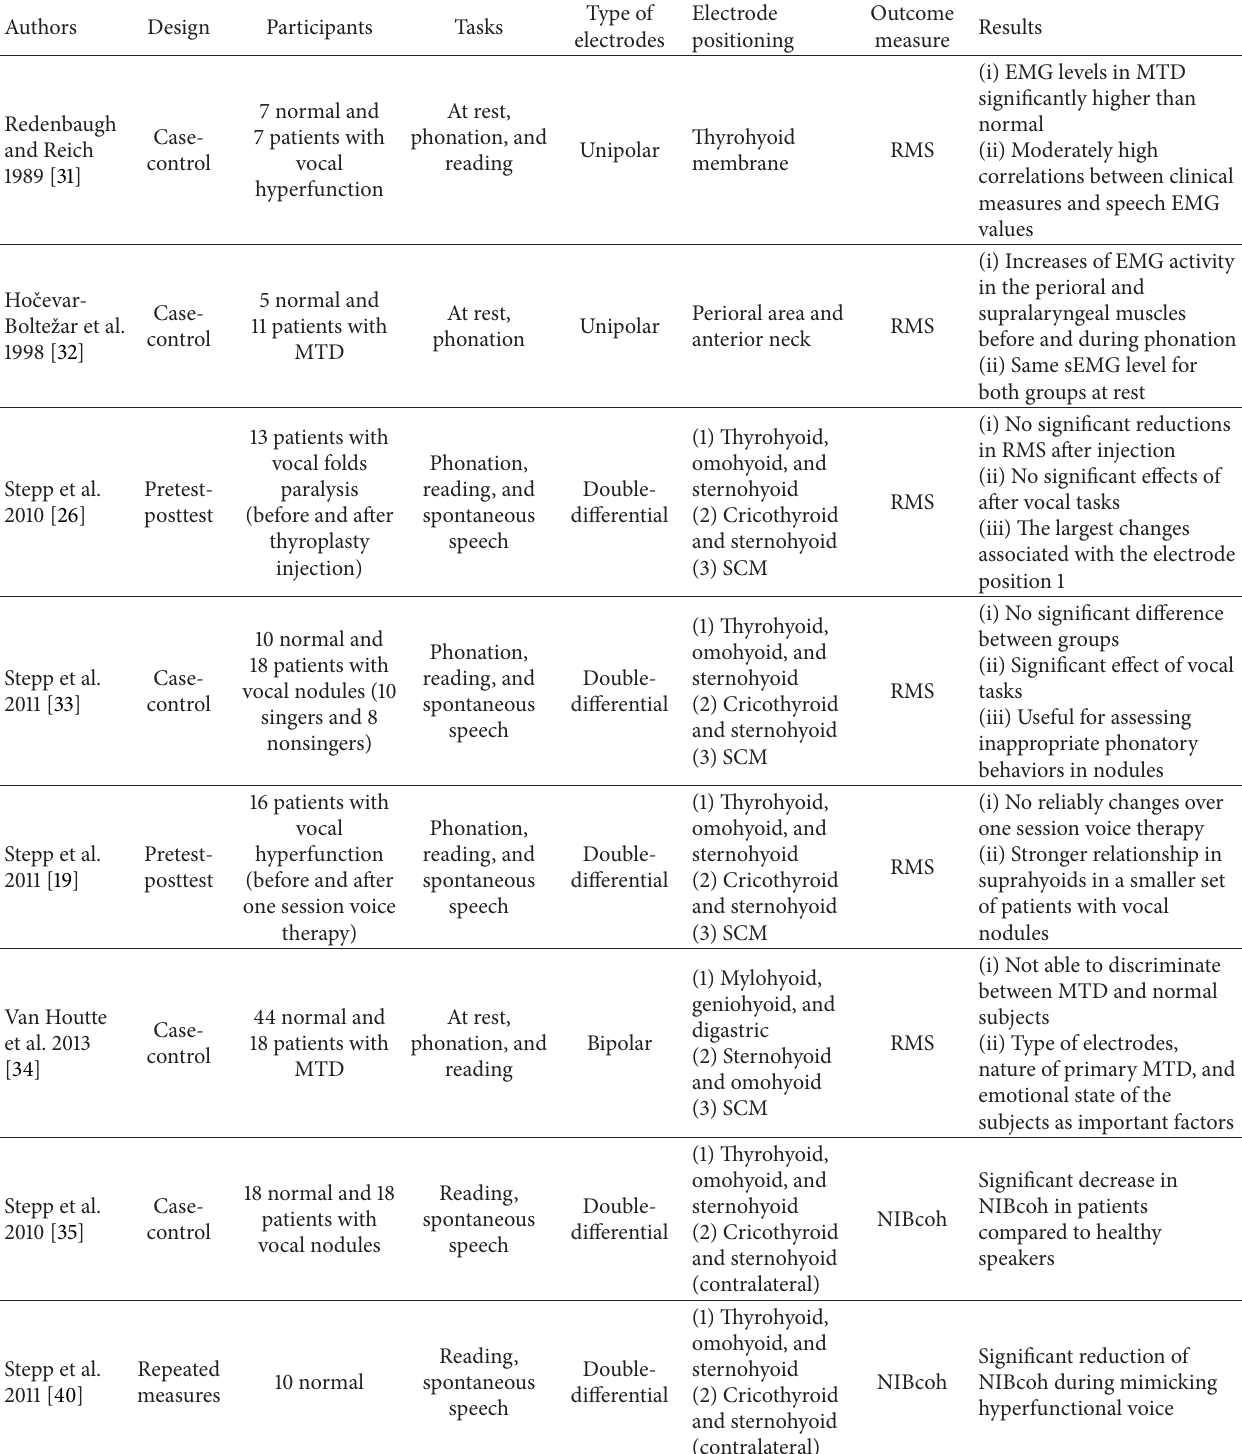
Table 1: Summaries of studies using surface